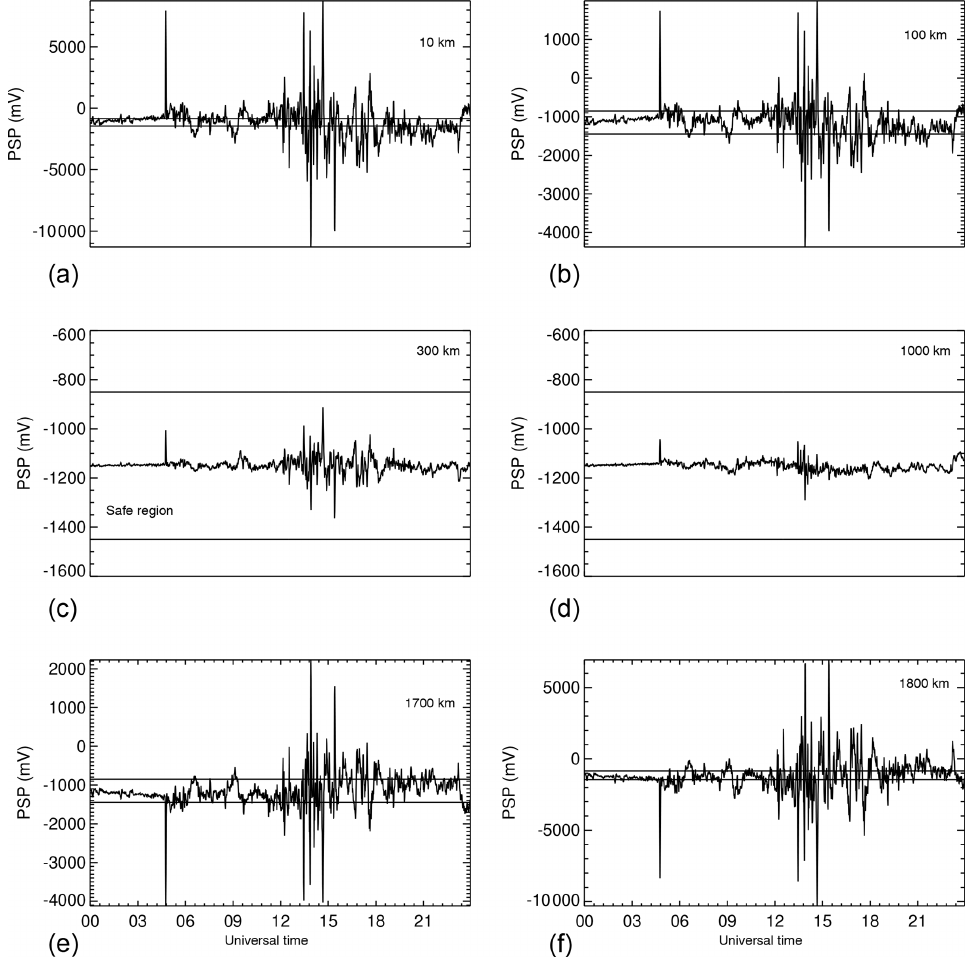
Figure 4. Pipe-to-soil potential obtained by DSLT theory for different sites (values in km at the top right of each panel) along the GASBOL pipeline for a terminating impedance of 1000 (cid:127) during the 17 March 2015 geomagnetic storm. Solid lines delimit the safe range of the GASBOL